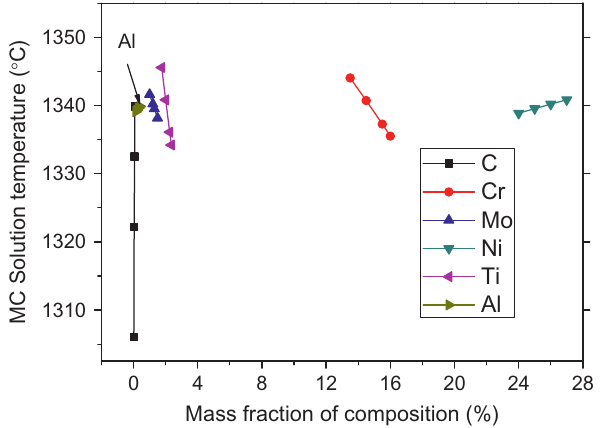
Figure 13: Influence of different elements on solution temperature of MC